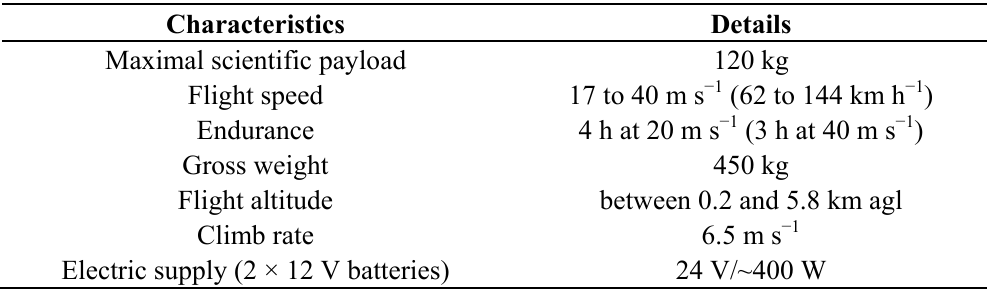
Table 1. Main characteristics of the ULA a